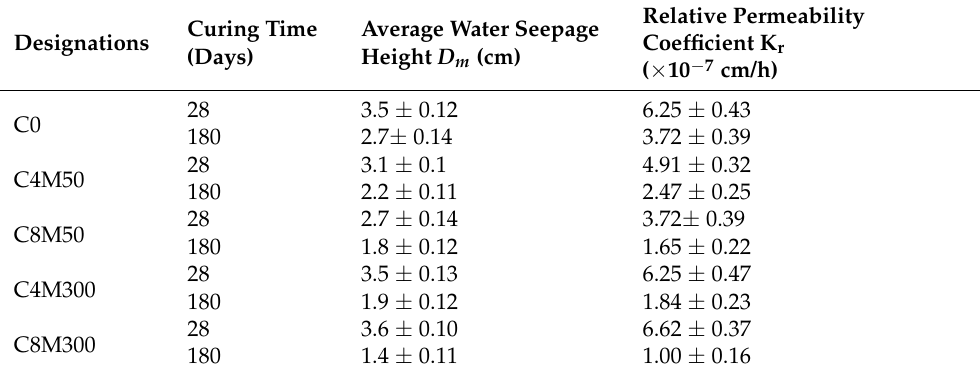
Table 3. The 28-day and 180-day permeability of concretes containing MgO with different reactivity and